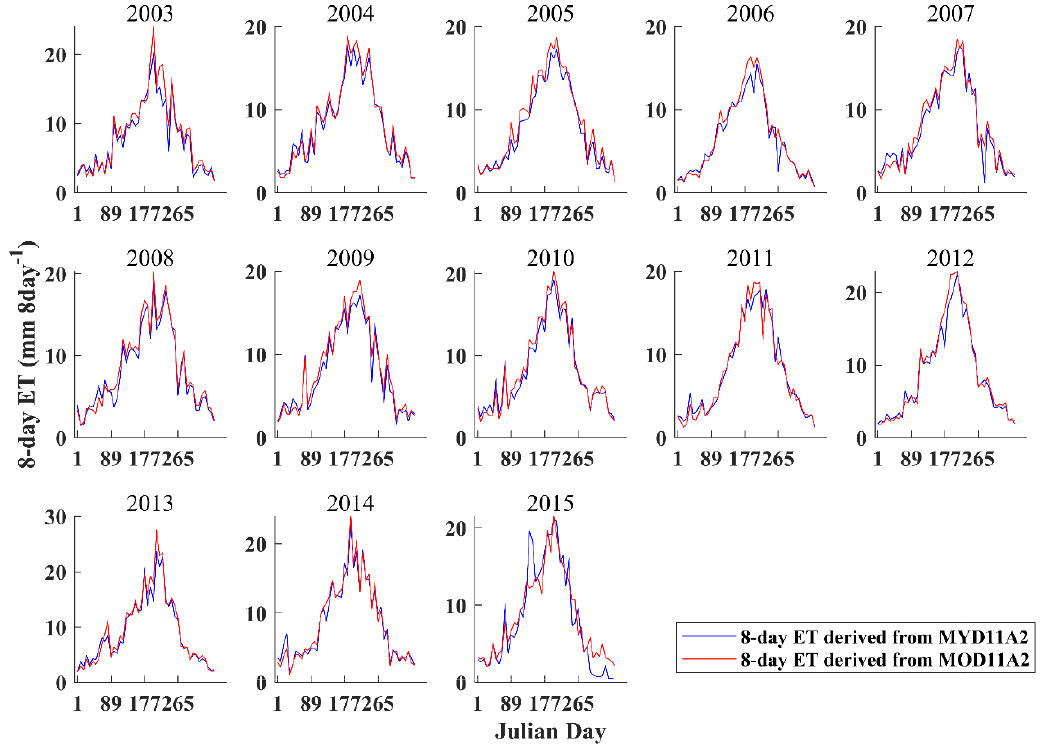
Figure A9. Eight-day ET derived from the MOD11A1 and MYD11A1 over the whole YRB during the years 2003–2015.